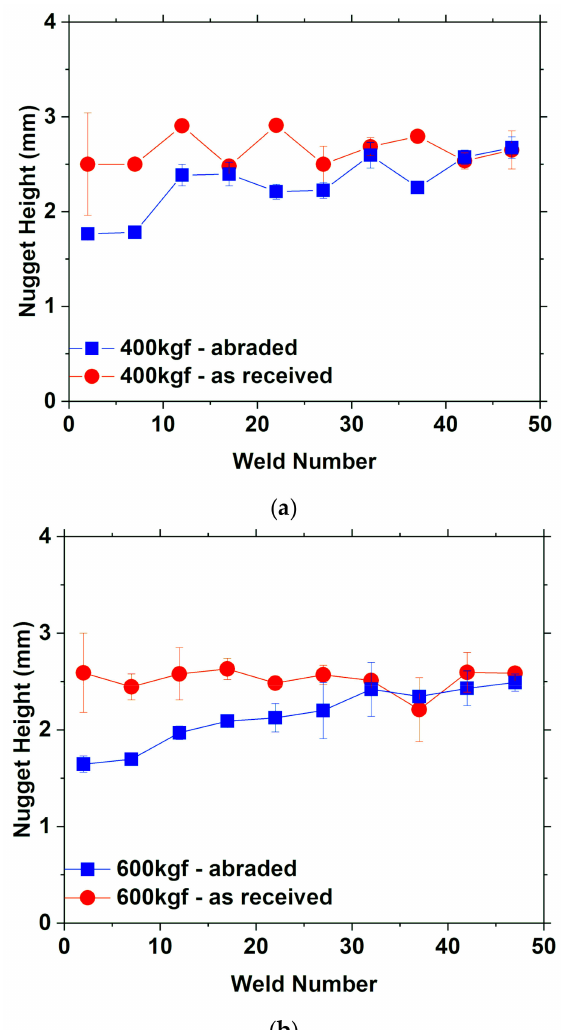
Figure 15. Measured height of the nuggets obtained using the as-received and the abraded electrodes at electrode forces of ( a ) 400 kgf and ( b ) 600 kgf.